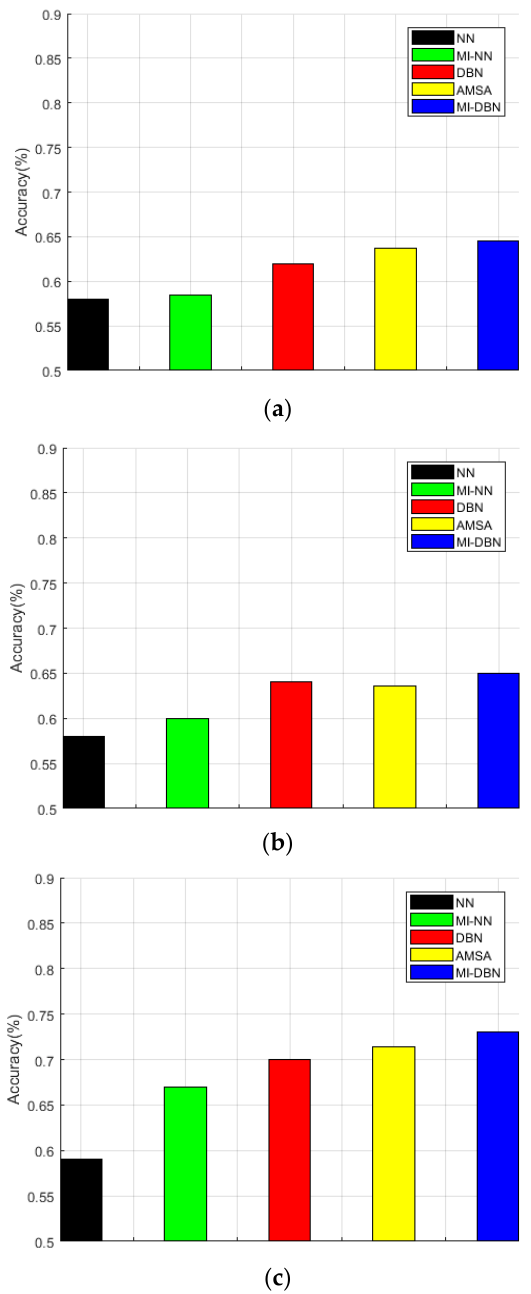
Figure 5. The tests of NN, MI-NN, DBN, AMSA, and MI-DBN with Forest Fires. The accuracies are plotted on the horizontal axis. ( a ) α = 10%; ( b ) α = 30%; ( c ) α =